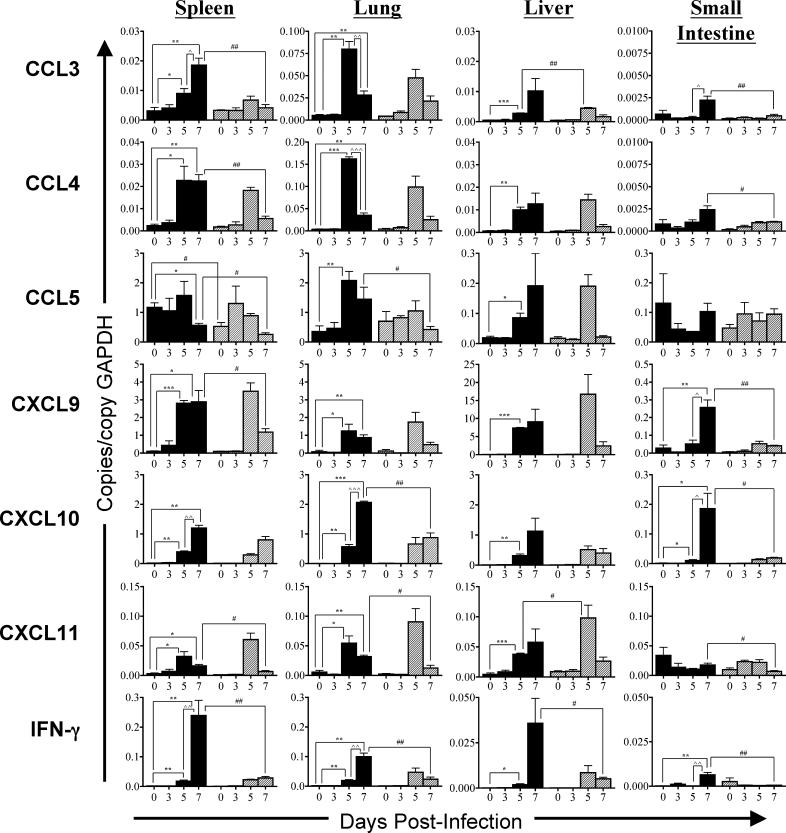
Expression of CCR5 and CXCR3 Chemokine Ligands and IFNγ in T. gondii-Infected MiceQuantitative PCR was performed on total RNA isolated from spleen, lung, liver, and small intestine of wild-type control and CCR5−/− C57BL/6 mice (female, 5–6 wk old, three or four mice per group) infected orally with 15–50 cysts of 76K strain of T. gondii. Tissues were harvested from uninfected and at days 3, 5, and 7 PI. Data are displayed as copies of cytokine or chemokine per copies of GAPDH, with wild type in black bars and CCR5−/− in hatched bars ± standard error of the mean. Statistics were performed using Student's t-test. Sets of symbols: * indicates comparisons with uninfected wild type, ^ indicates comparisons between days 5 and 7 PI; and # indicates comparisons between wild type and CCR5−/−. * p < 0.05, ** p < 0.01, *** p < 0.001, ^ p < 0.05, ^ ^ p < 0.01, ^ ^ ^ p < 0.001, # p < 0.05, ## p < 0.01, ### p < 0.001.